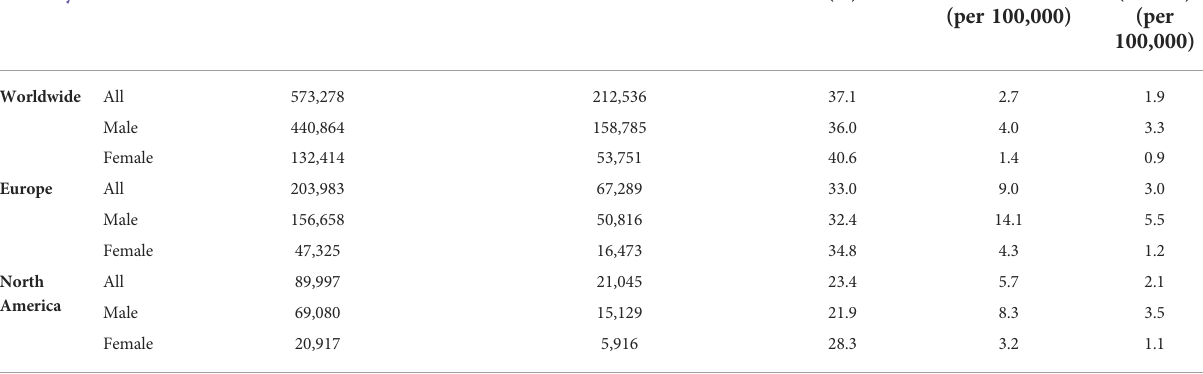
TABLE 1 Bladder cancer incidence and